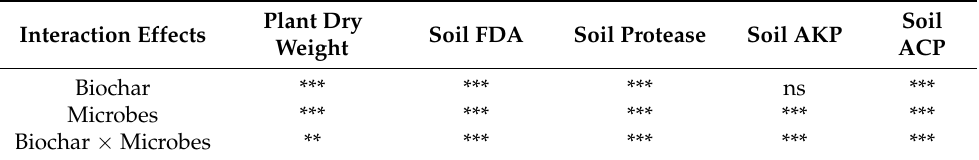
Table 1. Interaction effects of biochar and microbial inoculants on the plant dry weight and the activities of soil fluorescein diacetate (FDA) hydrolase, protease, alkaline phosphomonoesterase (AKP), and acidic phosphomonoesterase (ACP).